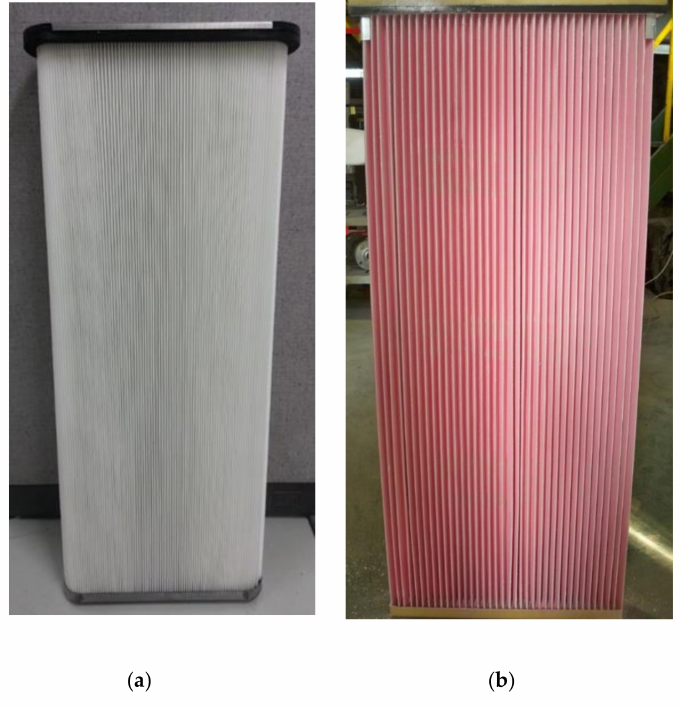
Atmosphere 2019 , 10 , x FOR PEER REVIEW Figure 10. Photos of filters ( a ) before and ( b ) after the experiment.